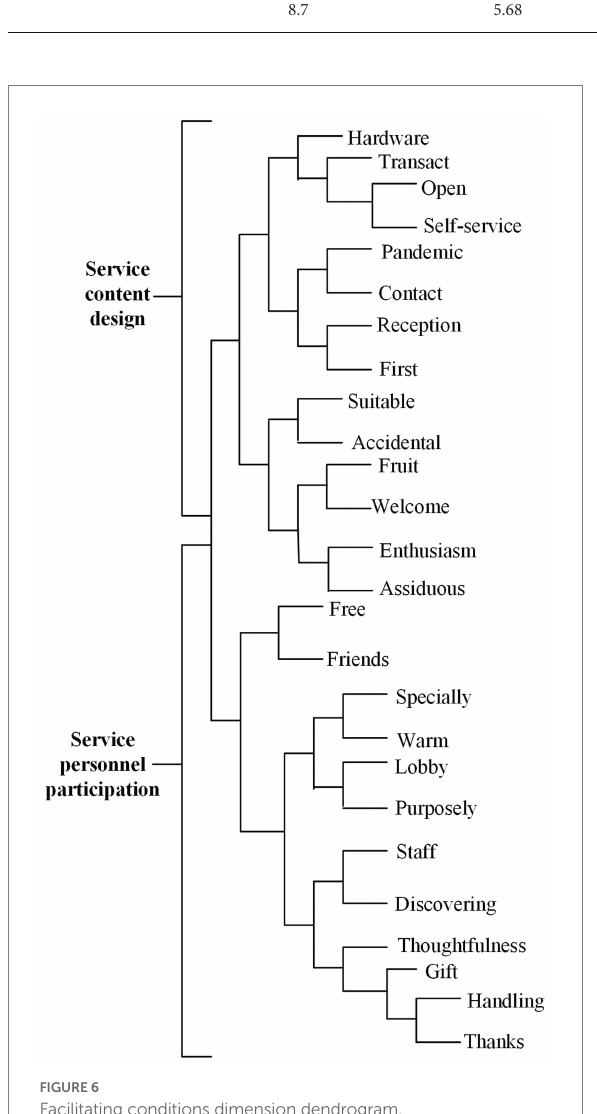
FIGURE 6 Facilitating conditions dimension